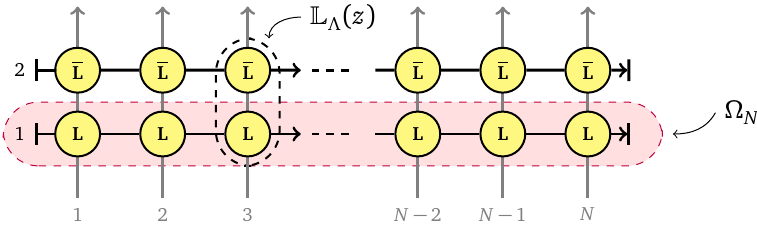
Ω † Figure 3: Matrix-product representation of the non-equilibrium steady state ρ ∞ = Ω : the N N amplitude operator Ω is represented by the degrees of freedom residing in the bottom row N (shown in pink), while its conjugate transpose Ω † corresponds to the upper row. In terms of an N auxiliary scattering process, auxiliary particles are depicted by black lines and propagate in the horizontal direction. They can be viewed as fictitious particles composed of canonical bosons, fermions of complex (super)spins, emanating from the auxiliary vacuum on one end and ab- sorbed by the same vacuum at the other end. Physical degrees of freedom (shown by gray vertical lines) are on the other hand associated to N fundamental particles of gl ( n | m ) Lie super- algebra. The off-shell steady-state density operator admits an interpretation as a vacuum con- traction of a homogeneous two-row monodromy operator (cid:77) Λ ( z ) = (cid:76) Λ ( z ) (cid:254)(cid:76) Λ ( z ) (cid:254) ··· (cid:254)(cid:76) Λ ( z ) , where (cid:76) Λ ( z ) = L Λ ( z ) ⊗ ¯ L Λ ( z ) is a Lax operator which acts on each vertical